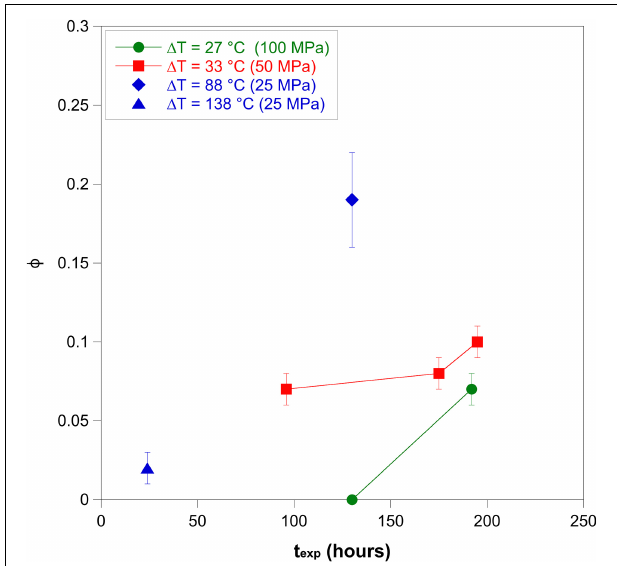
FIGURE 6 | Crystal fraction of alkali feldspar ( φ ) as function of the experimental duration (t exp ).